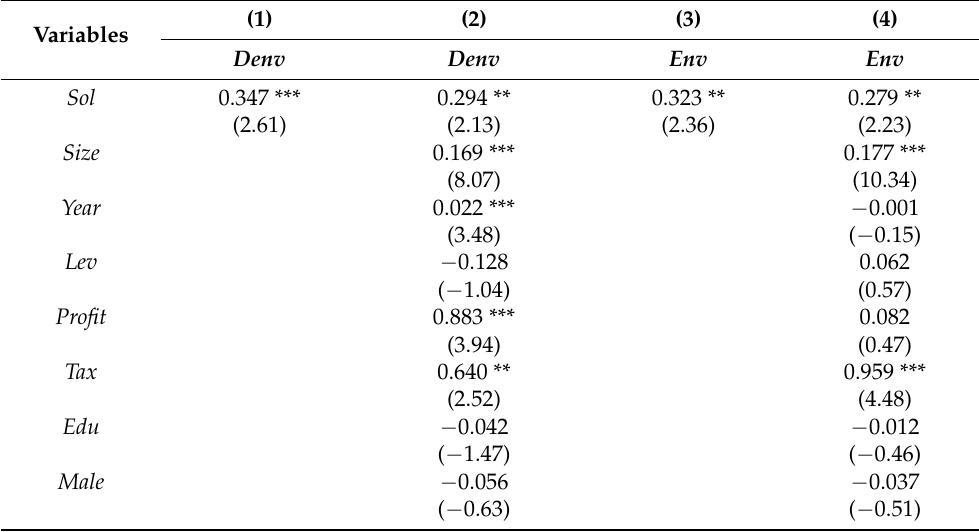
Table 3. The effect of military experience on corporate environmental